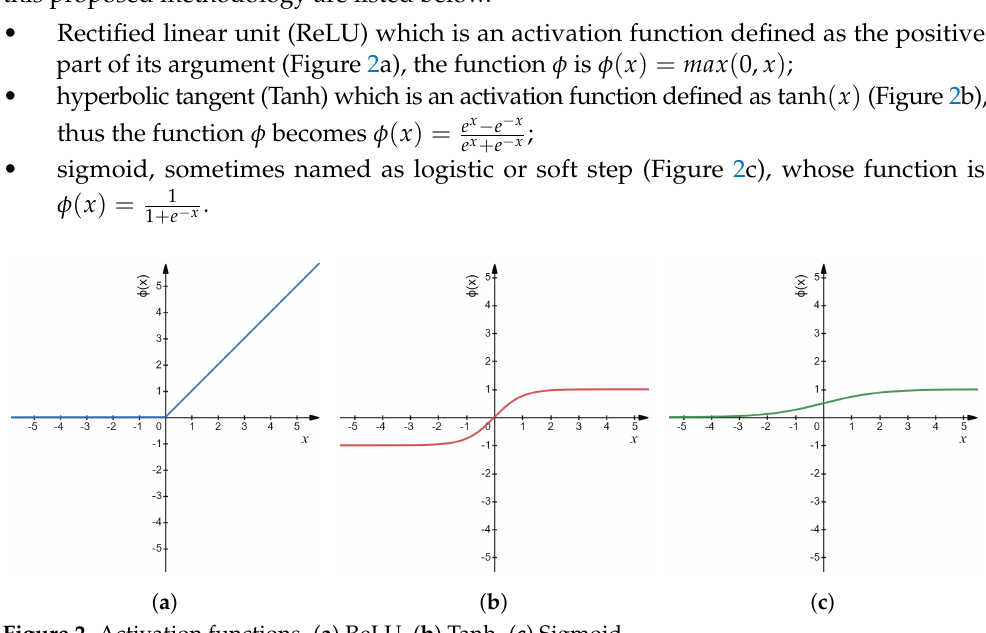
Figure 2. Activation functions. ( a ) ReLU. ( b ) Tanh. ( c )